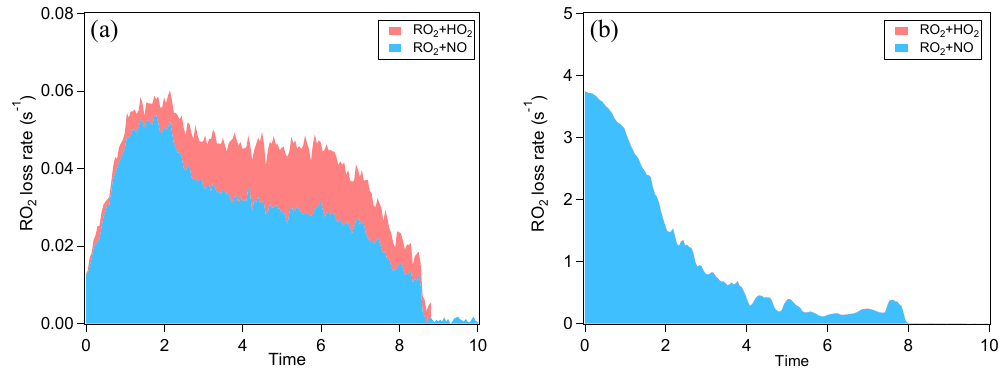
Figure 1. Typical loss rate of RO 2 by RO 2 + NO and RO 2 + HO 2 in the low-NO x (a) and the high-NO x (b) conditions of this study. The experiments at low SO 2 are shown. The RO 2 + HO 2 rate is stacked on the RO 2 + NO rate. Note the different scales for RO 2 loss rate in panel (a) and (b) . In panel (b) , the contribution of RO 2 + HO 2 is very low and barely noticeable.